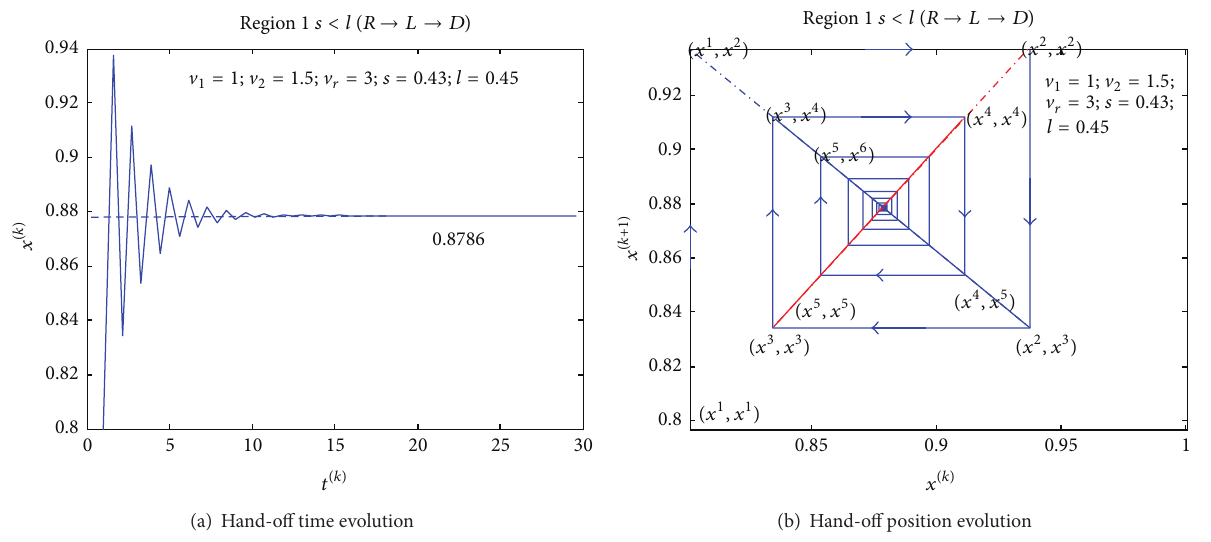
Figure 4: Convergence process in Region 1 when the picking routes are sequenced as 𝑅 → 𝐿 → 𝐷